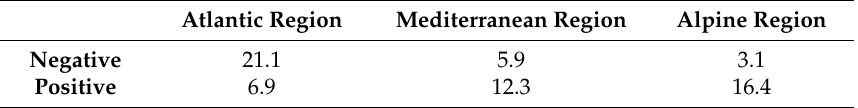
Table 3. Percentage of pixels, by biogeographical region, that exhibit positive and negative significant normalized difference vegetation index (NDVI) trends.